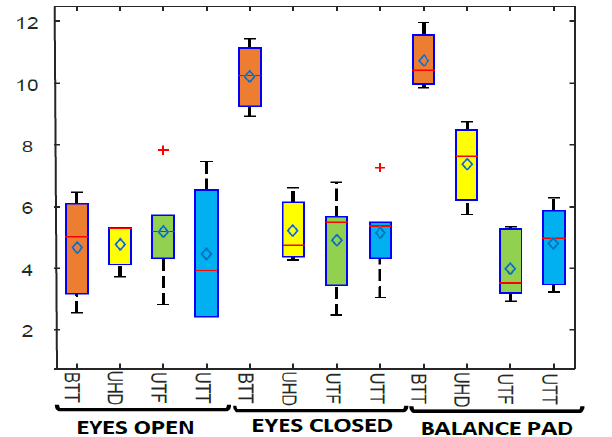
Figure 1: comparison of ML distance of postural sway for different levels of amputation. BTT/UTT=bilateral/unilateral trans-tibial, UTF= unilateral trans-femoral, UHD= unilateral hip disarticulation. Conditions 1=eyes open, 2=eyes close, 3= standing on the foam. Note significant differences between unilateral and bilateral